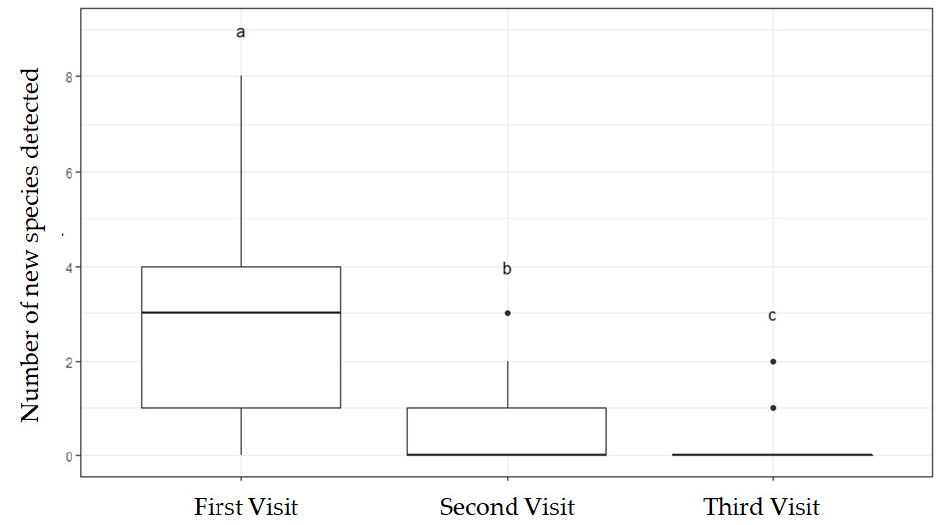
Figure 4. Number of new species detected calculated by transect ( n = 98) depending on the number of visits. Box plots indicate median, range, and first and third quartiles. Points indicate outliers. Significant differences are indicated by different letters.